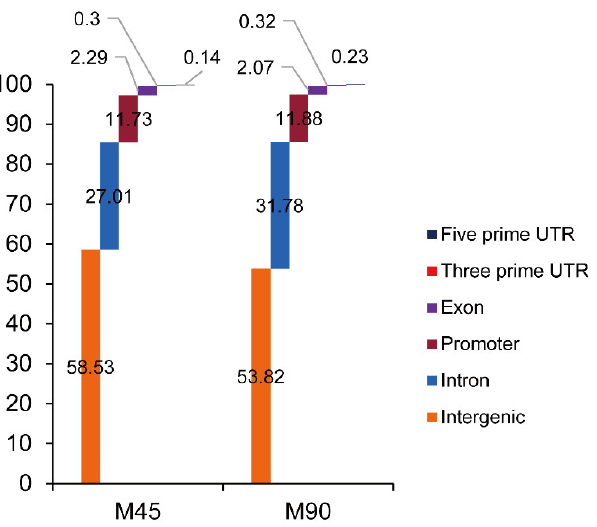
Figure 6. Read distribution of CTCF chromatin immunoprecipitation sequencing (ChIP-seq) among sheep genomes. According to the genome coordinates of reads, reads can be divided into six categories, including in intergenic region, intron region, promoter region, exon region, 3′ untranslated region (UTR) and 5′ untranslated region.